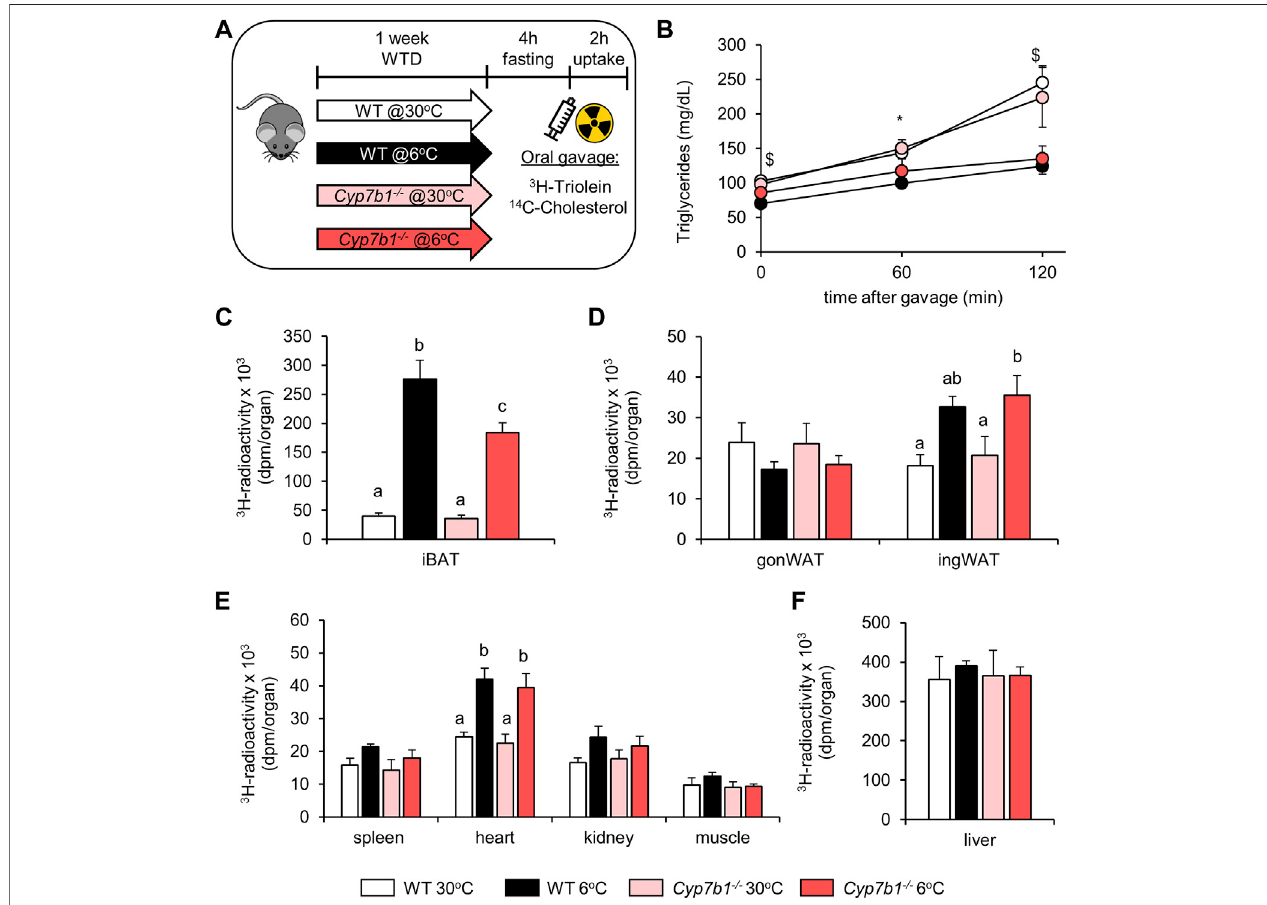
FIGURE 2 | Cyp7b1 deletion compromises cold-induced fatty acid uptake into BAT. WT and Cyp7b1 − / − littermates fed a WTD were housed for 1 week either at thermoneutral (30 ° C) or cold (6 ° C) environment before being subjected to a fat tolerance test (OFTT) with 3 H-triolein/ 14 C-cholesterol-traced oral gavage. Experimental setup (applies also to Figure 3 ) (A) , plasma triglyceride levels (B) and total uptake of 3 H-triolein in brown (C) and white (D) adipose tissue depots as well as other metabolic organs (E , F) (n = 5/group). Data are shown as mean values ±SEM. For (B) , p values lower than 0.05 were considered statistically signi fi cant and are indicated as follows: $ = WT30 vs. WT 6; * = WT 6 vs. KO 30; # = WT 30 vs. KO 6; and & = KO 30 vs. KO 6. For (C – E) , different letters indicate signi fi cant differences between groups ( p < 0.05) determined by two-way ANOVA.